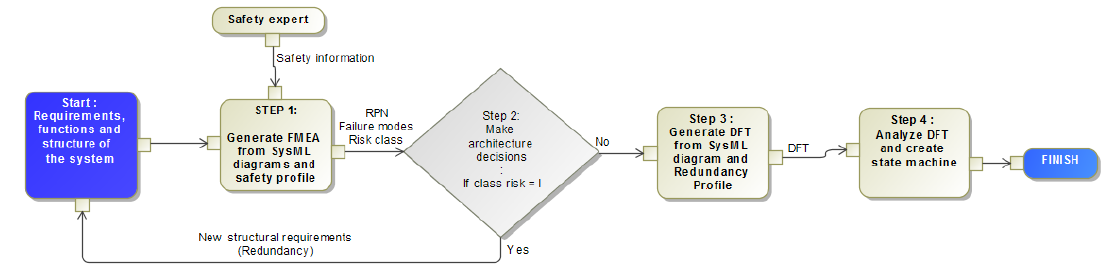
Figure 1. Improved SafeSysE: flowchart of the general